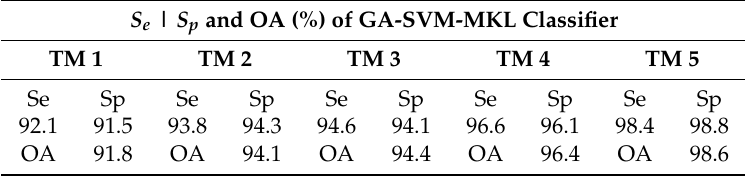
Table 5. Performance Evaluation of GA-SVM-MKL classifier in each tunable modes (TM).